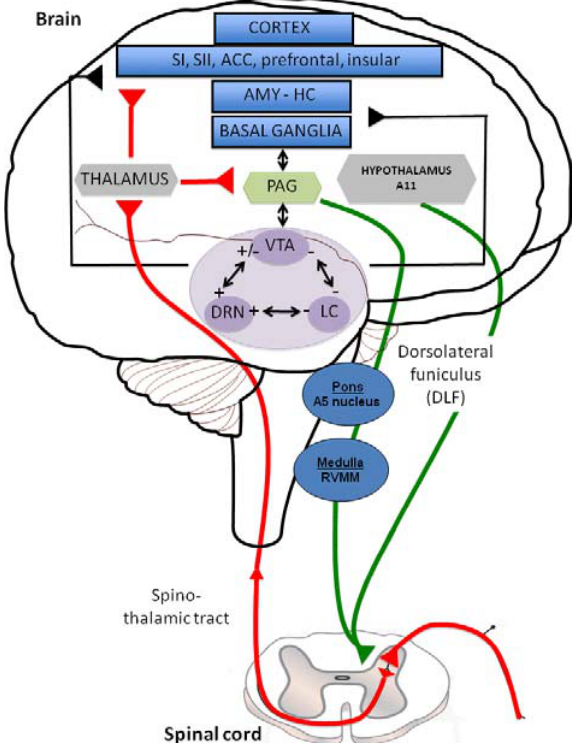
Figure 1. Schematic illustration of the main pathways involving monoaminergic systems in the modulation of pain